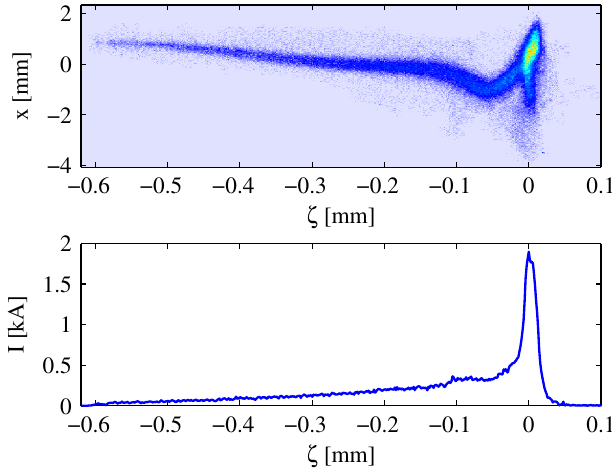
FIG. 3. (Color) Top: Two-dimensional CCD image of a single compressed electron bunch whose longitudinal charge density profile is translated into a spatial distribution on an OTR screen. The bunch head at the right side. Bottom: Current as a function of the internal bunch coordinate (cid:2) . The peak current is 1.8 kA with an estimated uncertainty of 10%.